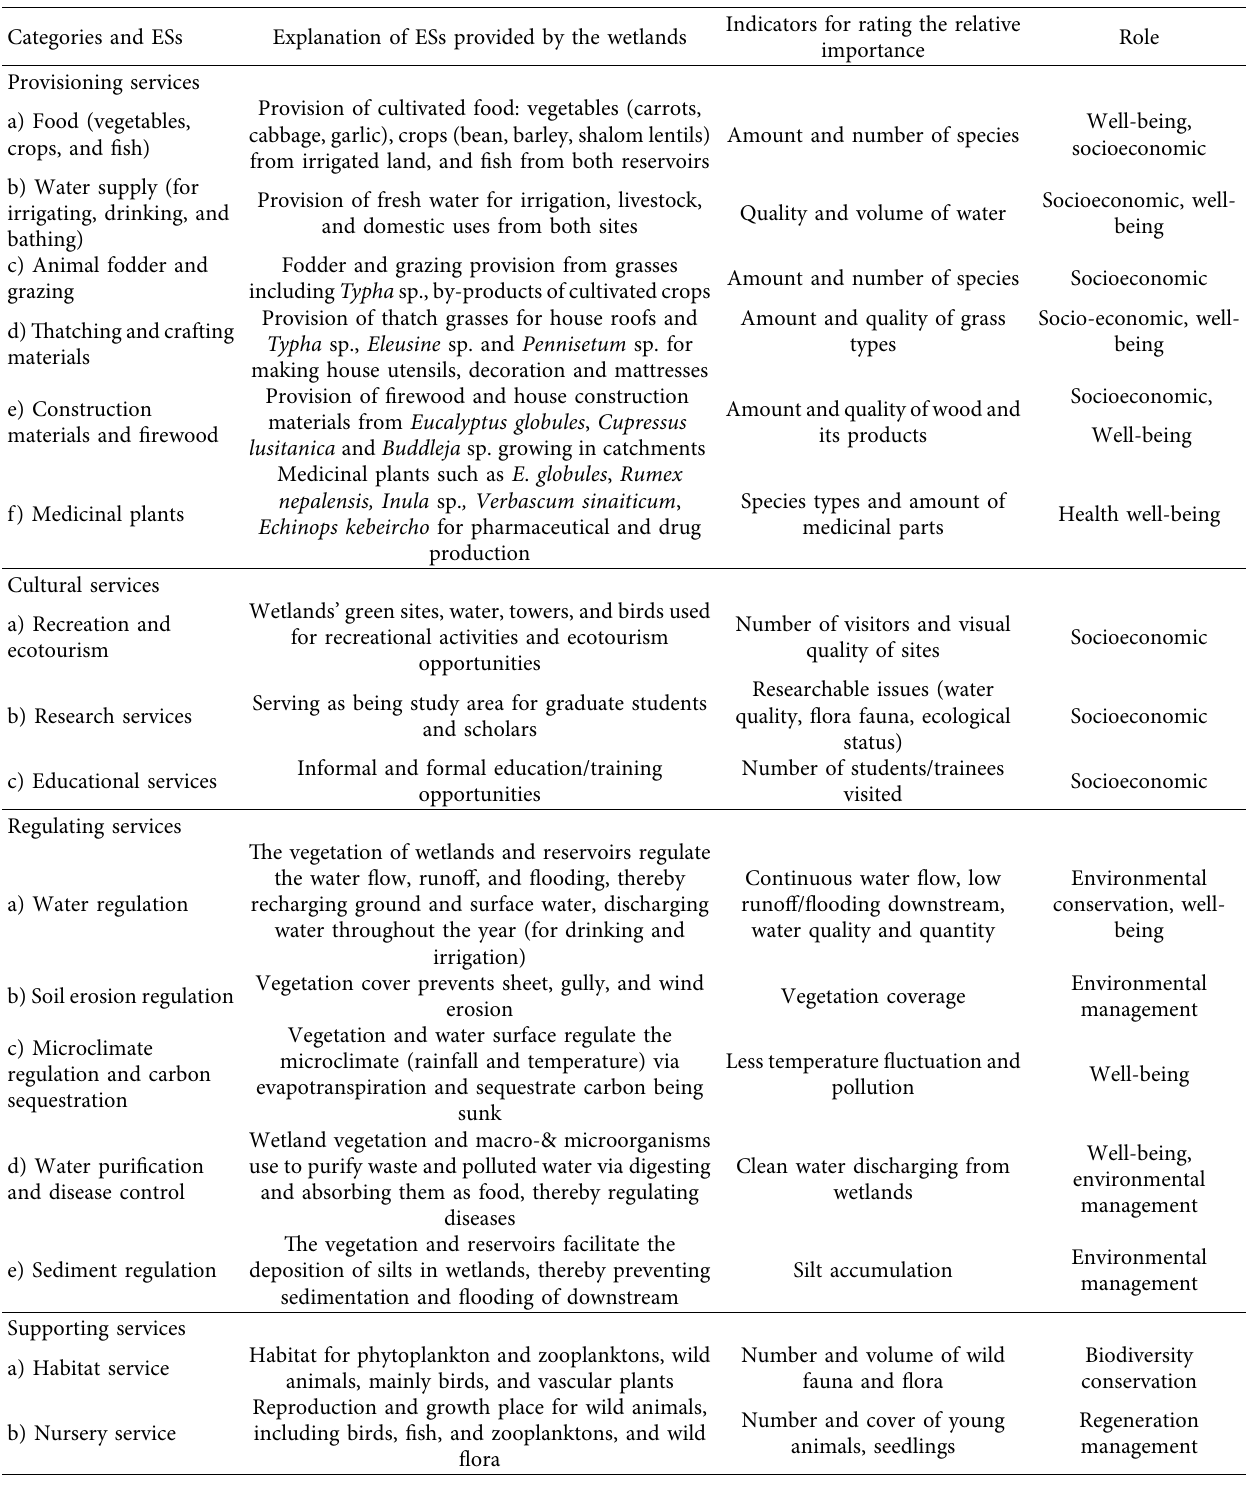
Table 7: The ESs delivered by the artificial wetland ecosystems and their explanations, indicators, and